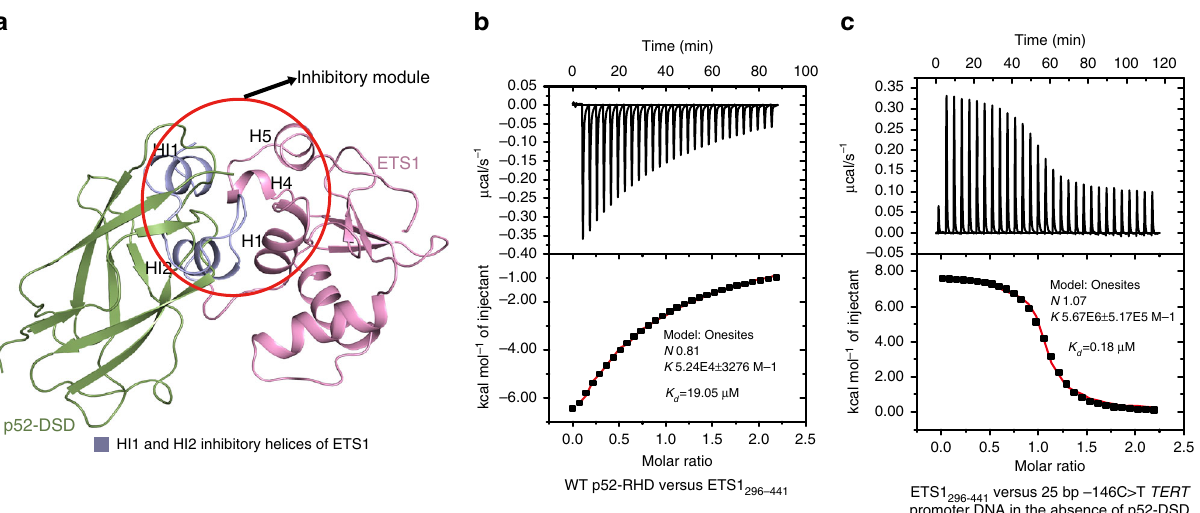
Fig. 4 p52-DSD counteracts autoinhibited state of ETS1. a Superposition of the ETS1 molecule of the p52/ETS1/ − 146C>T complex onto the autoinhibited ETS1 (PDB code: 1R36) shows a steric clash between p52-DSD and the inhibitory helices HI1 and HI2 of ETS1. ETS1 in the p52/ETS1/ − 146C>T complex is omitted for clarity. b ITC titration of p52-RHD and ETS1 296 – 441 containing the HI1 and HI2 inhibitory helices. c ITC titration of ETS1 296 – 441 and a 25 bp − 146C>T TERT promoter DNA in the absence of